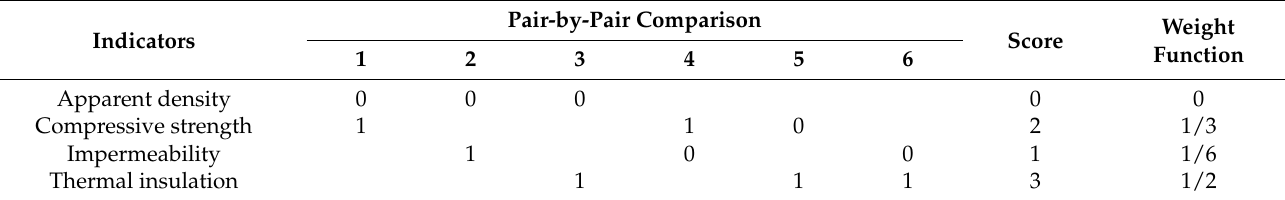
Table 5. Weighting of evaluation indicators.